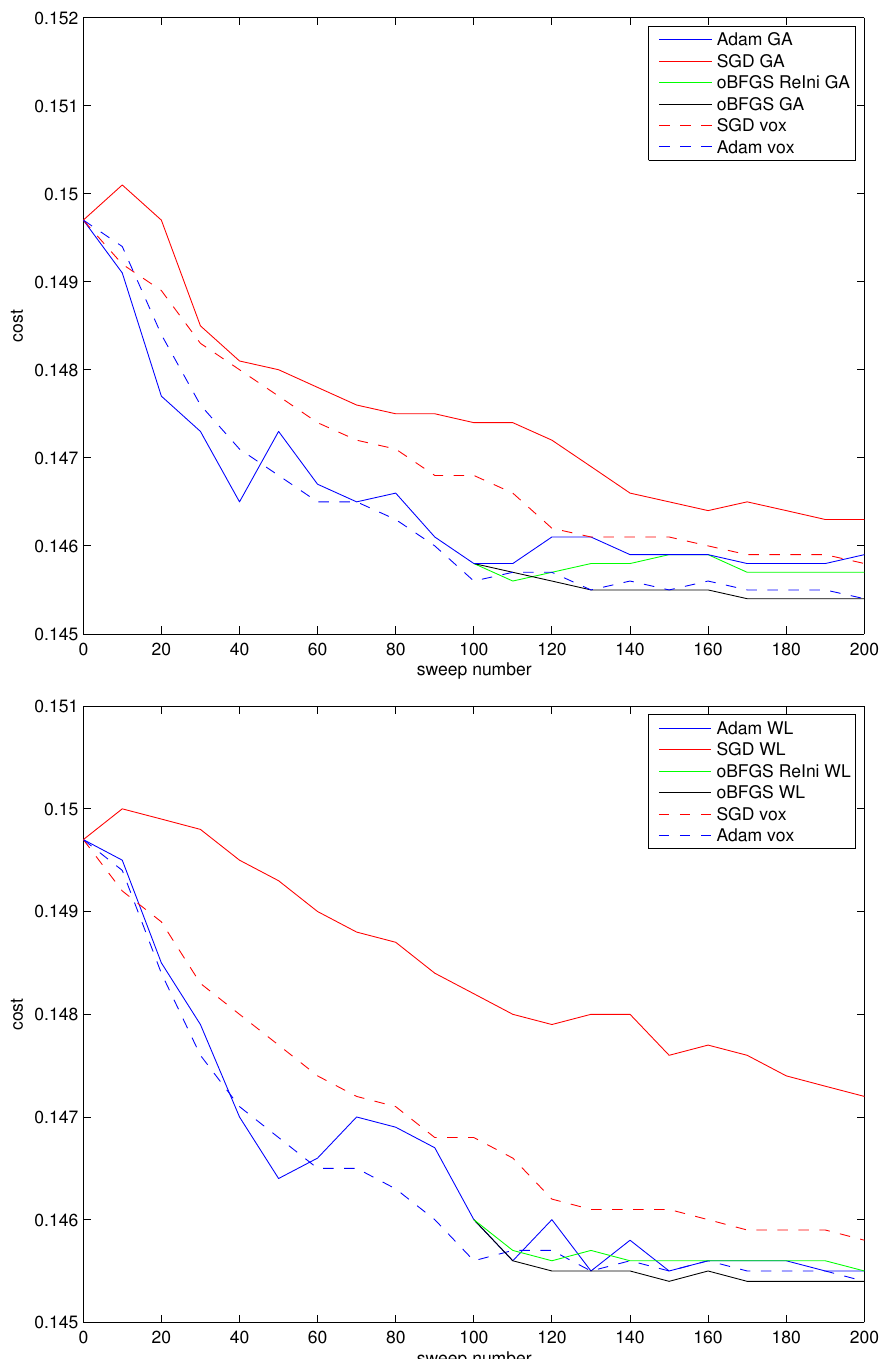
Figure 2. Cost versus sweep number. Top image: Gaussian Radial Basis Functions (RBF); Bottom image: Wendland RBF. The blue, red, green and black curves refer, respectively, to the following algorithms: Adam, SGD, oBFGS with reinitialization every N ReIni = 10 sweeps and oBFGS (without reinitialization). The dashed lines correspond to level set pixel-based Adam and Stochastic Gradient Descent (SGD)